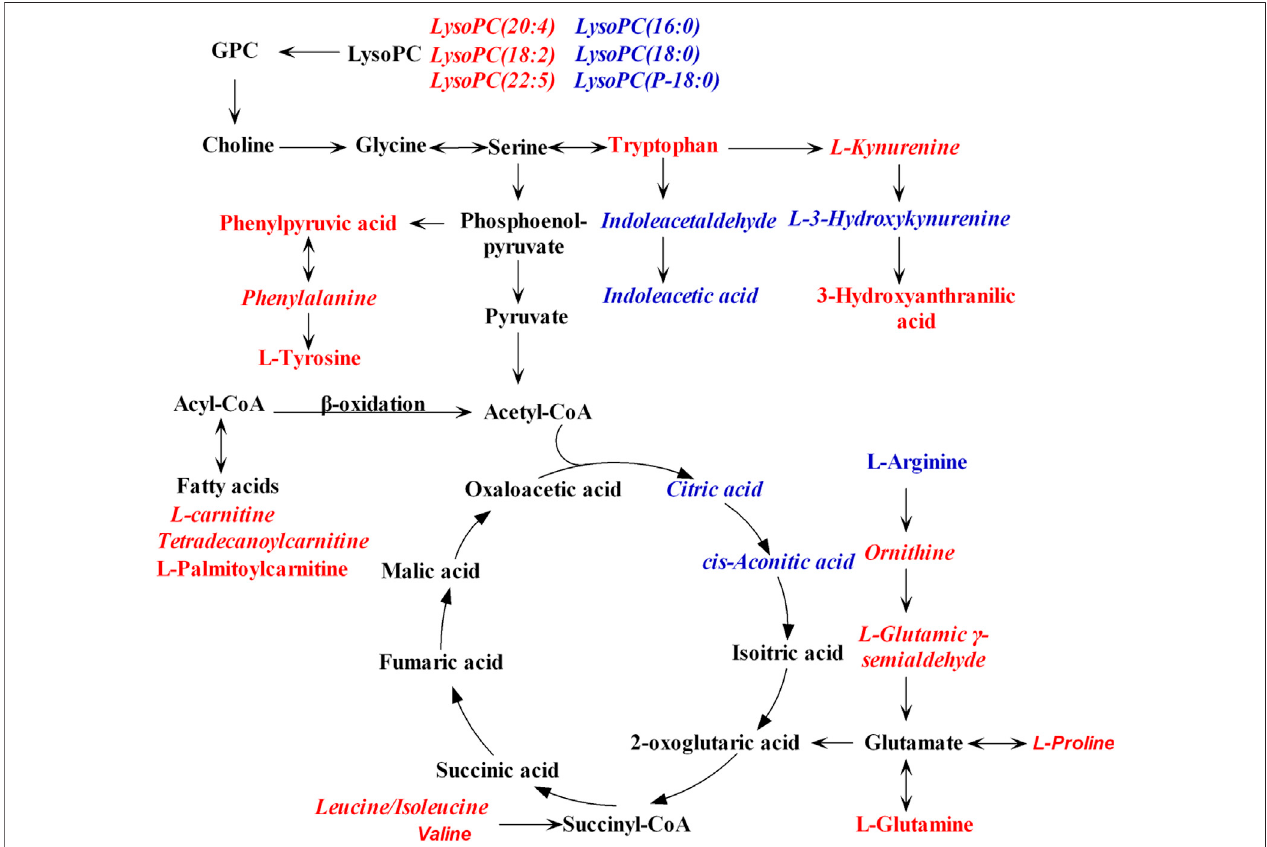
FIGURE 7 | Schematic metabolic network of LPS/D-GalN-induced ALF and MHD modulation based on the KEGG database. Red: the levels of metabolites in model group were up-regulated compared to control group. Blue: the levels of metabolites in model group were down-regulated compared to control group. The italic metabolite names were signi fi cantly reversed by MHD treatment. Abbreviations: LysoPC, Lysophosphatidylcholine; GPC, Glycerophosphocholine.